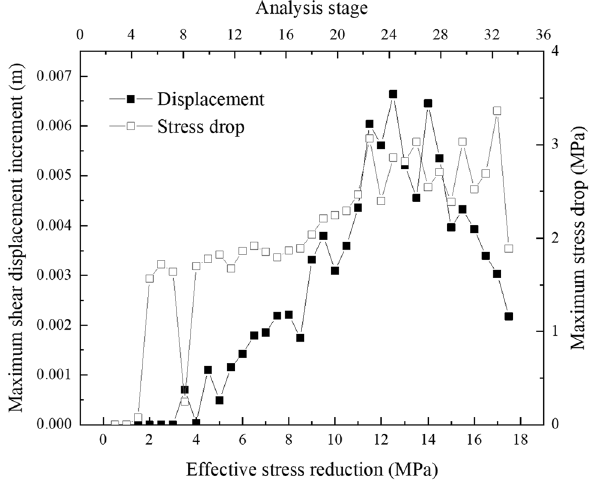
Fig. 16 Maximum shear displacement increment and stress drop at each analysis stage